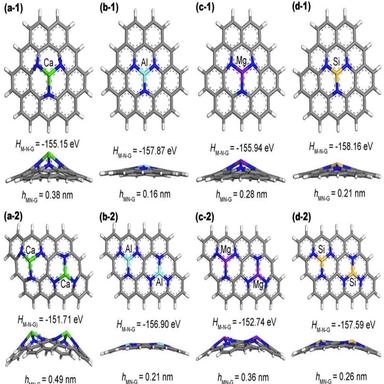
Optimized structures of N-G doped by: (a-1) one Ca atom, (b-1) one Al atom, (c-1) one Mg atom, (d-1) one Si atom, (a-2) two Ca atoms, (b-2) two Al atoms, (c-2) two Mg atoms, and (d-2) two Si atoms. (A colour version of this figure can be viewed online.)